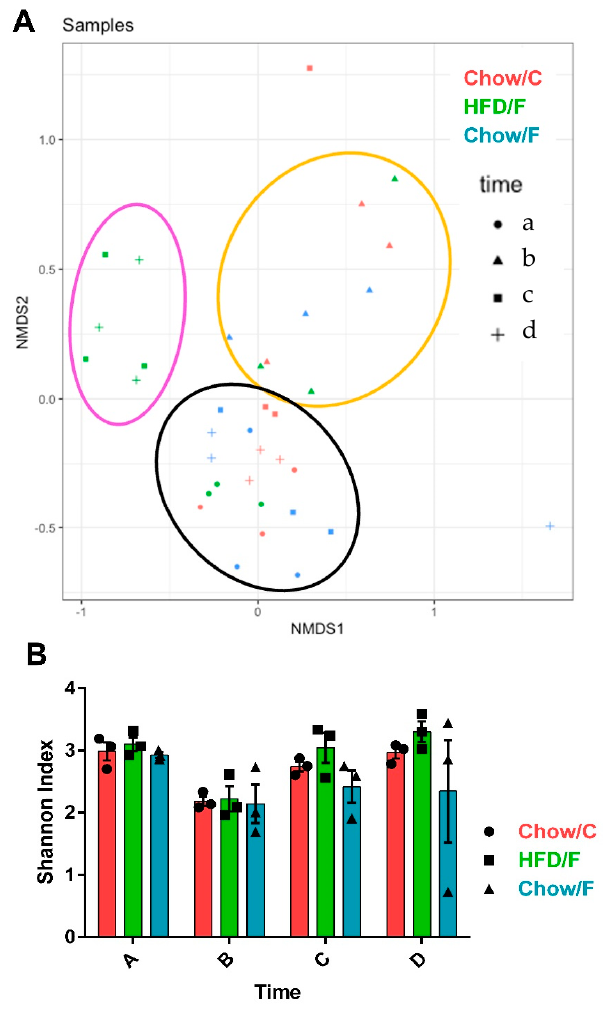
Figure 5. Consumption of a high-fat diet triggered remodeling of the gut microbiota. Samples were taken for microbiota analysis at four points throughout the experiment: a—before surgery, b—after recovery from surgery, c—four weeks after introduction of a high-fat diet, and d—at the end of the experiment. ( A ) Principal component analysis showed that all animals clustered together at baseline. After surgery, all animals clustered together and away from their baseline profile (b). Four weeks after introduction of the high-fat diet, the high-fat fed group clustered away from their post-surgery and baseline profile. The chow fed animals clustered with their baseline profile (c). At the endpoint, all chow fed animals clustered with their baseline profile, and the high-fat fed cohort clustered away (d). ( B ) Shannon index shown as mean + SEM for each group and time point. Bacterial diversity was slightly decreased after the surgery but recovered to pre-surgery levels within a few